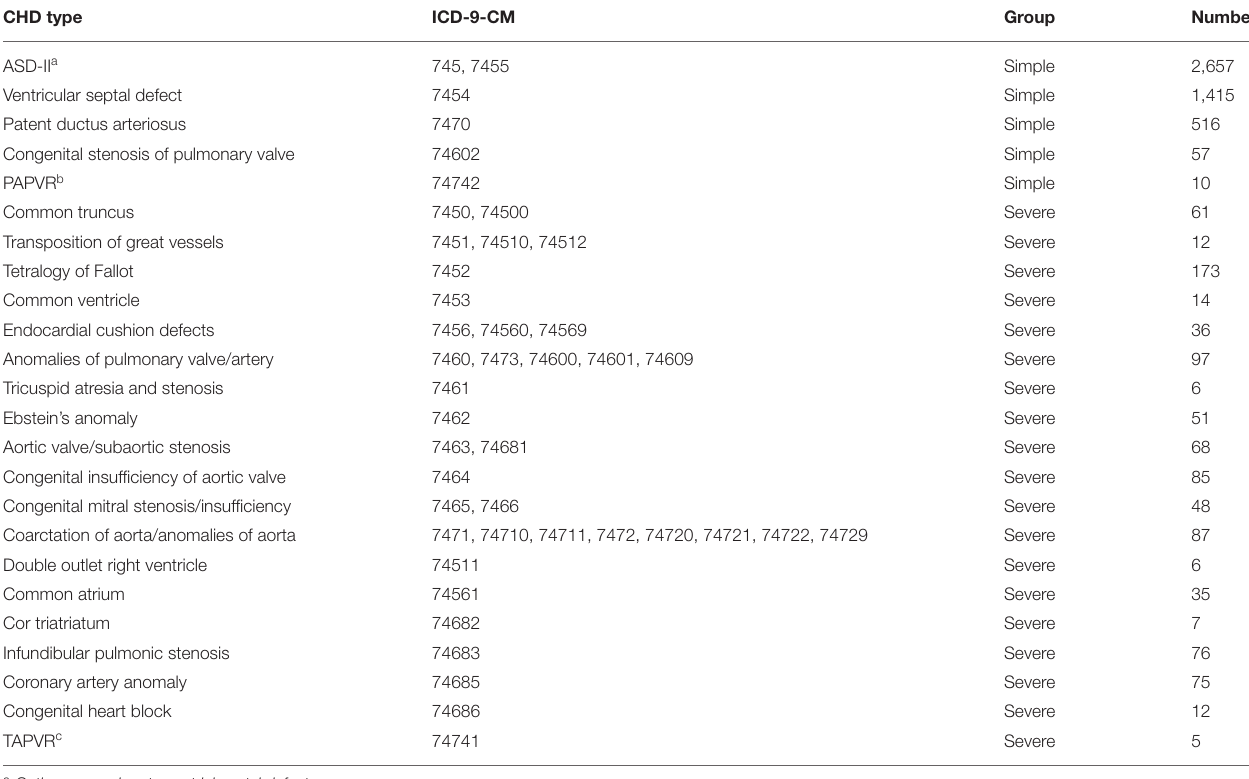
TABLE 3 | The distribution of congenital heart diseases.